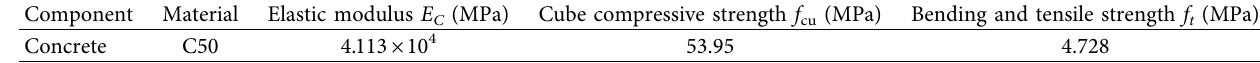
Figure 3: Structure of the overhanging SCCB. Table 1: Mechanical properties of concrete.